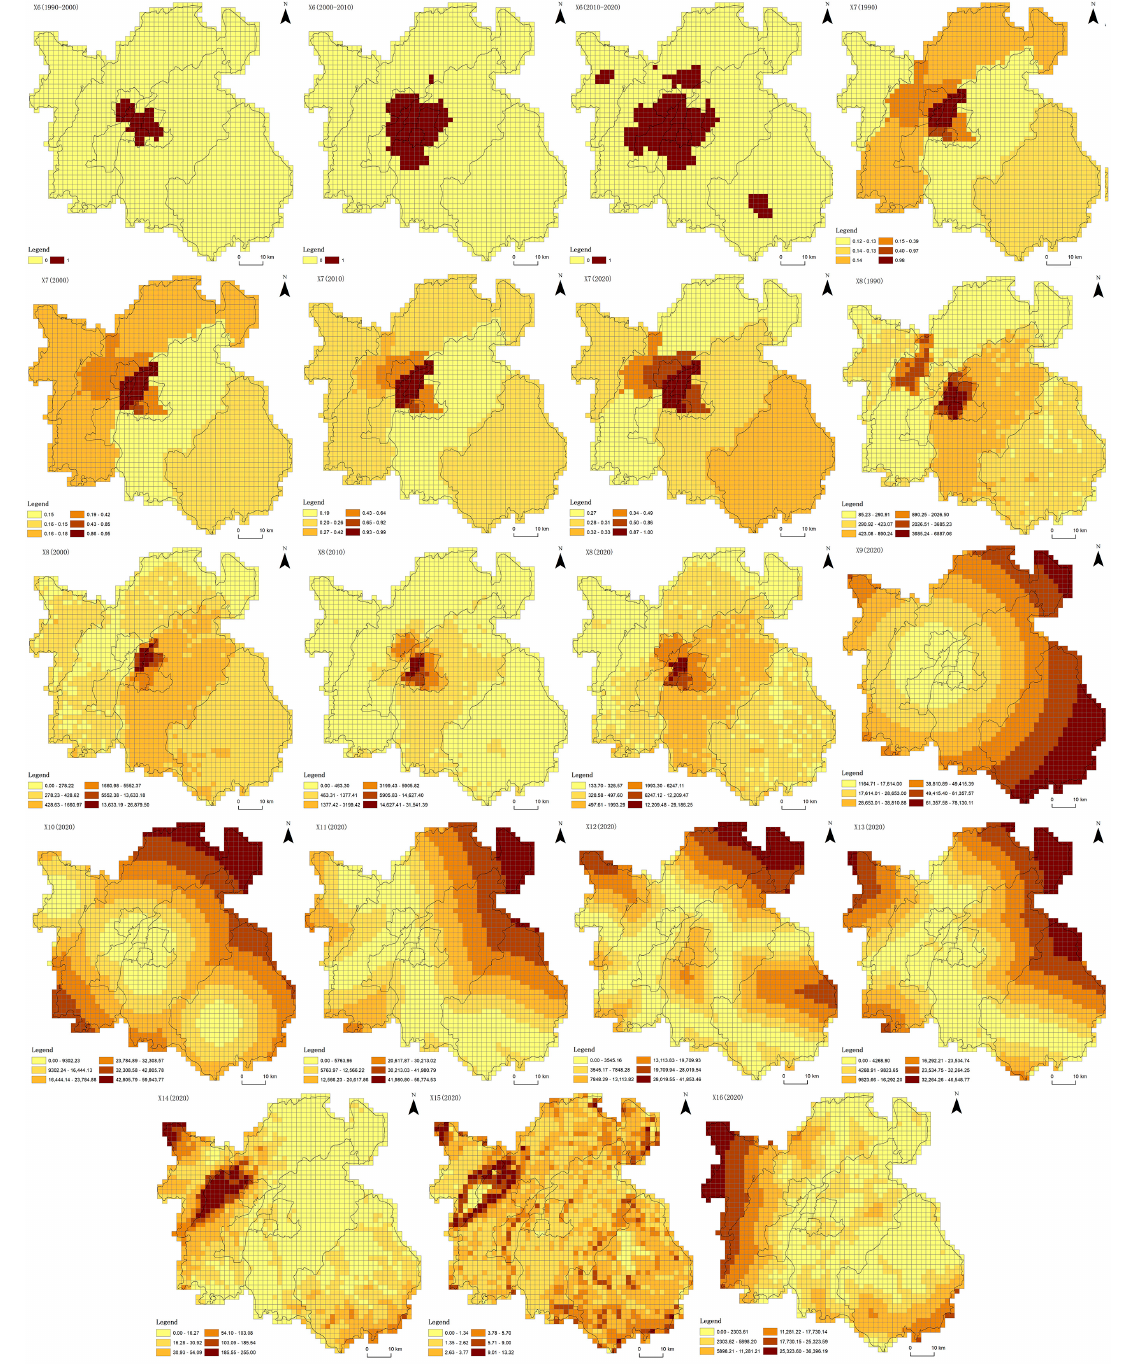
Figure 8. Spatial distribution of the value of impact factors 1 . From 2000 to 2010, the order of strength of the explanation for the expansion of con- struction land is as follows: X6 (0.504) > X5 (0.311) > X10 (0.305) > X8 (0.230) > X1 (0.217)